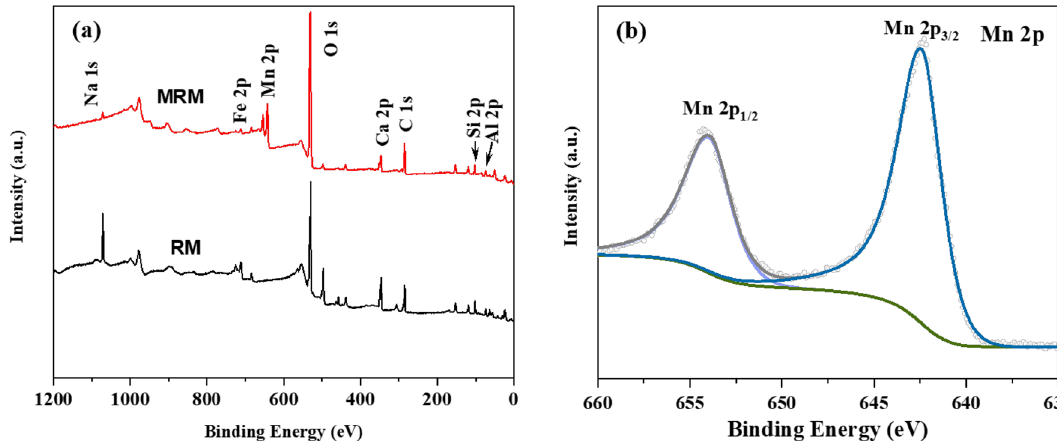
Figure 1. Full-scan XPS spectra of ( a ) RM and MRM and ( b ) Mn 2p spectra of